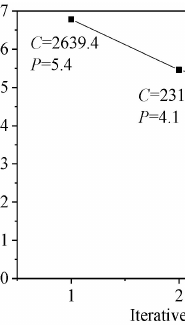
Figure 18. Average error with iterative times at 0 ◦ C.